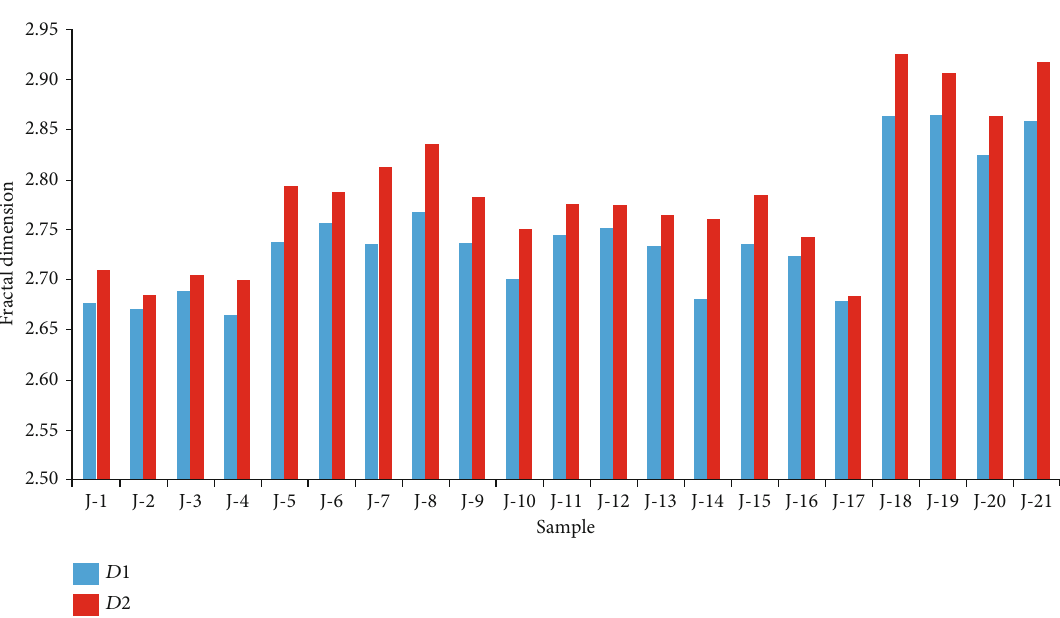
Figure 6: Fractal dimensions of Longtan